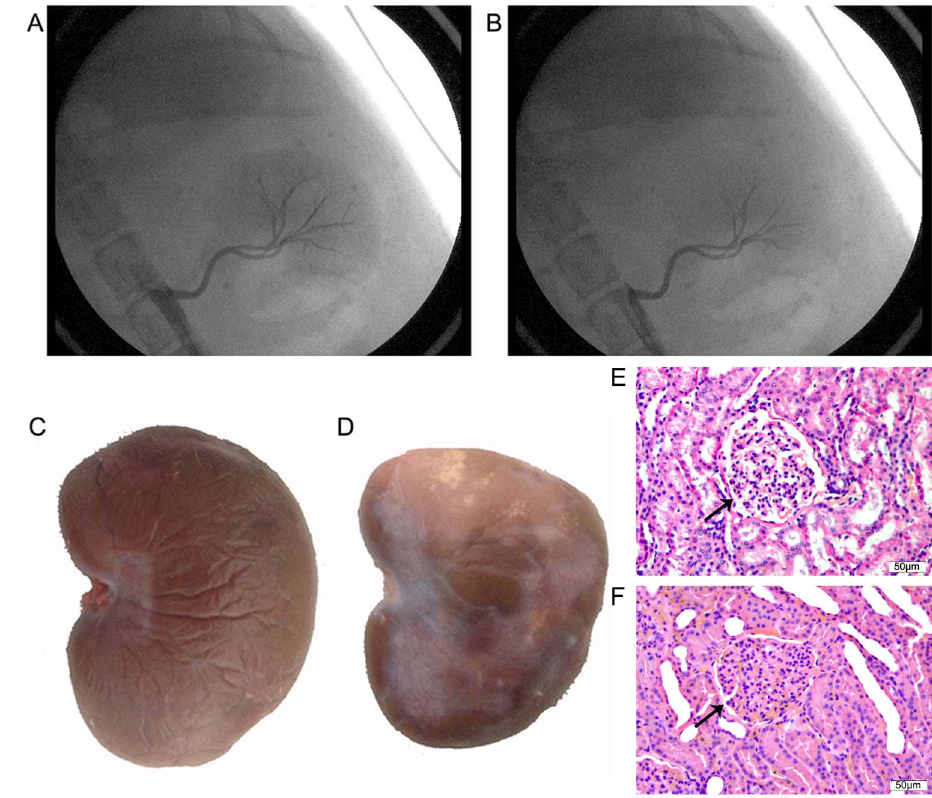
Figure 1. Images and morphological analysis of the left kidney. Images of left renal artery angiography before transcatheter embolization (A) and after transcatheter embolization (B) in the model group. Small renal artery branches were occluded, whereas the main renal artery or sub- segment renal artery remained fluent in the model group. Gross appearance of the left kidney after 2 weeks of interventional operation in the sham group (C) and the model group (D). The left kidney in the model group became pale and had atrophy and infarction. Images of HE staining of the left kidney after 2 weeks of interventional operation in the sham (E) and model (F) groups. Glomeruli were severely damaged in the model group. Arrows show a glomerulus in the sham and model groups.